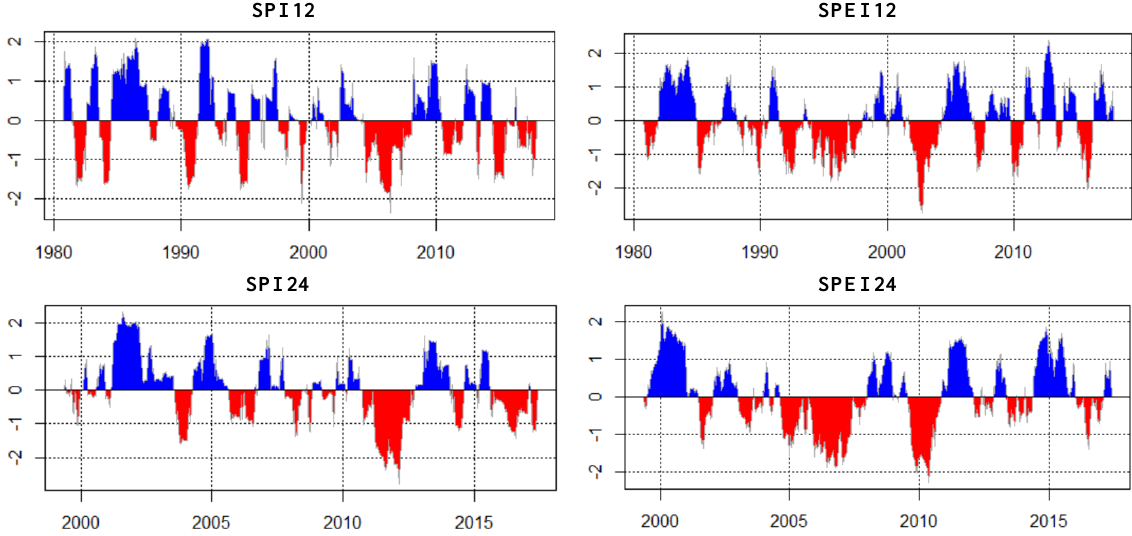
Figure 4. SPI (left) and SPEI (right) values for the selected Matam station in the Senegal River valley area, calculated over a